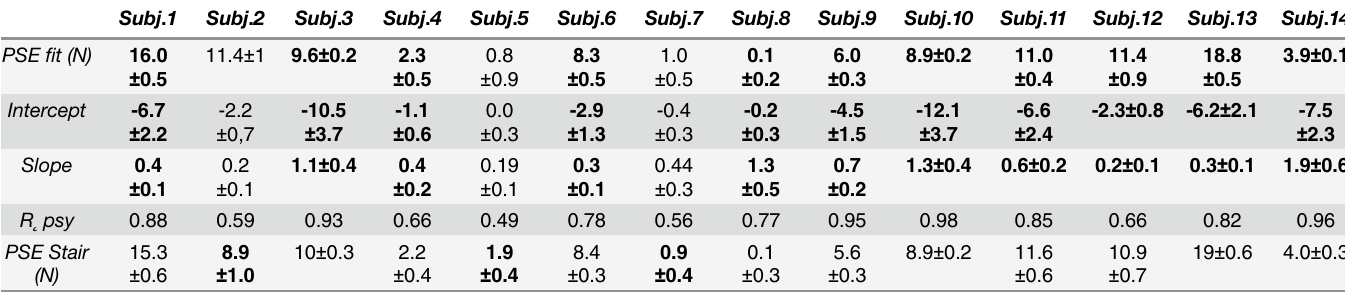
Table 1. Psycho-Metric Curve Parameters. Individual maximum likelihood (ML) estimated threshold ( PSE fit ), intercept and slope ± SE obtained by Logit glm fit describing the percentage of positive answers as function of upward force level. R 2 psy values describe the explained variance of the Logit function used to describe psychophysical decisions per each subject. PSE stair values were obtained by averaging the force levels associated with the last 10 rever- sals of the up-down staircase method. Bold values are those considered for further analysis. Either PSE fit or PSE stairs were used whether individual R 2 psy were higher (as well as equal) or lower than 0.60,